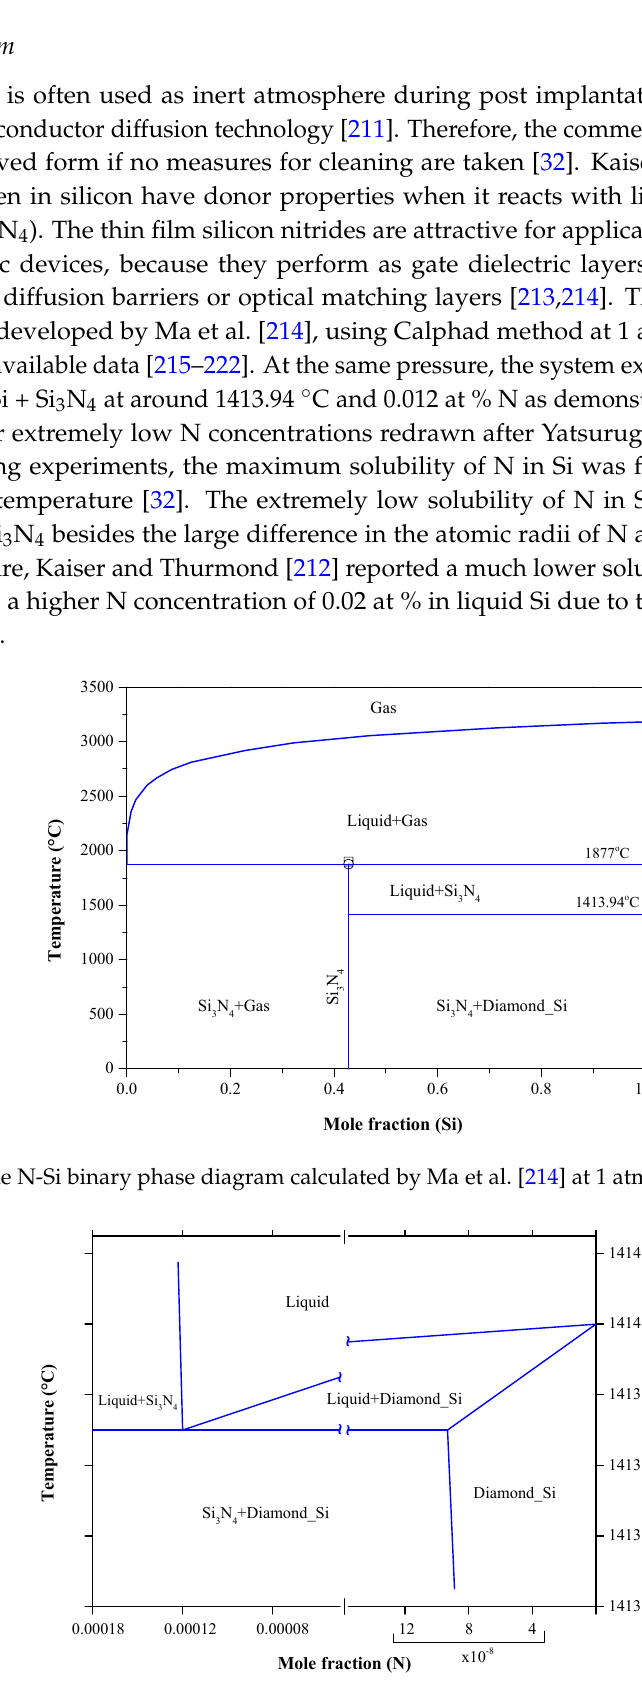
Figure 25. The N-Si partial phase diagram for the extremely low N concentration after Yatsurugi et al. [32].